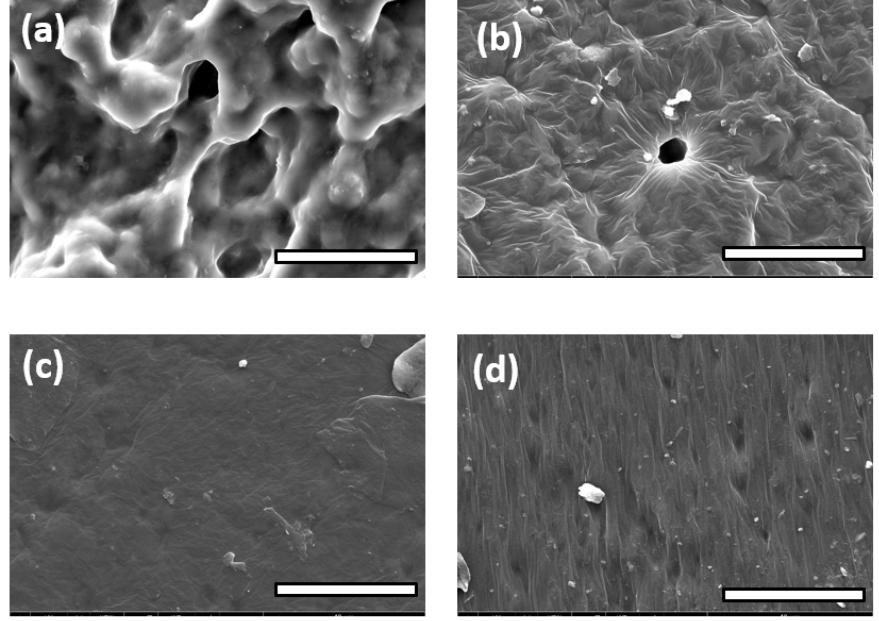
Figure 13. Images of FE-SEM observations from ( a ) PGS7, ( b ) PGS7-Co, ( c ) PGS8, and ( d ) PGS9. Scale bars = 40 µm.